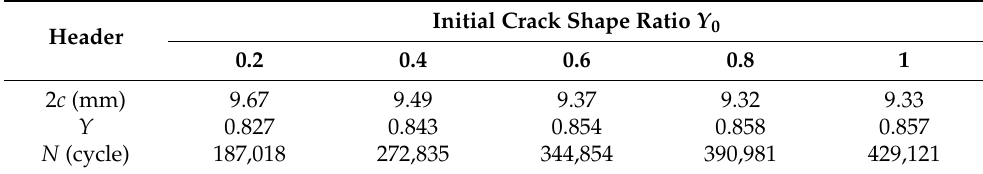
Figure 10. The a - N curve of the conical-cylindrical shell. Table 3. Fatigue life of conical-cylindrical shell with different shape